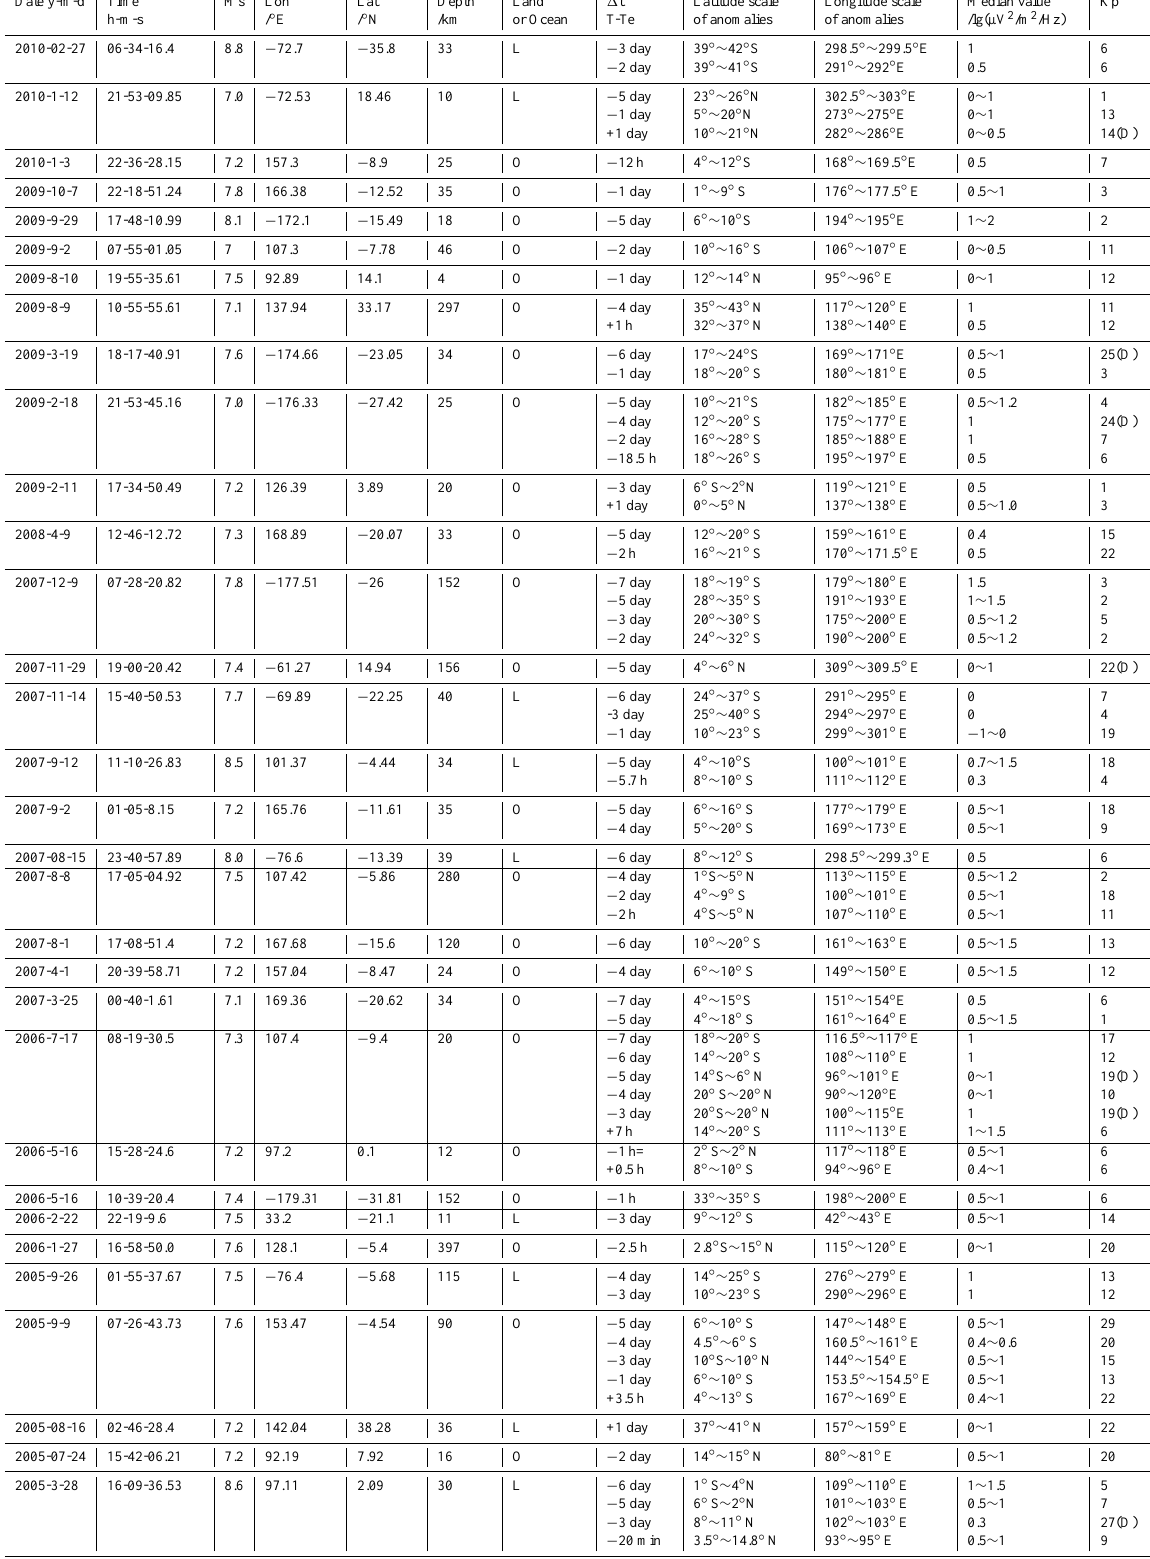
Table 1. Summary of anomalous information in ULF/ELF electric field related to strong earthquakes. Date y-m-d Time Ms Lon Lat Depth h-m-s / ◦ E / ◦ N